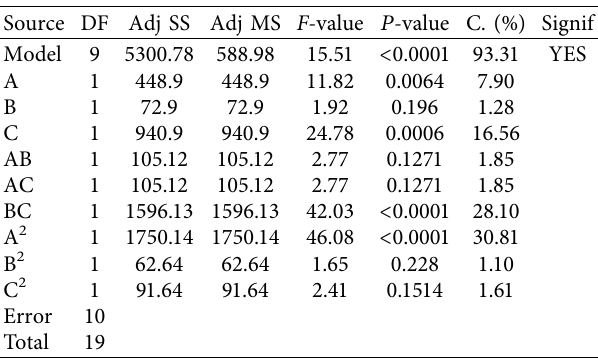
Table 6: Analysis of variance for HV